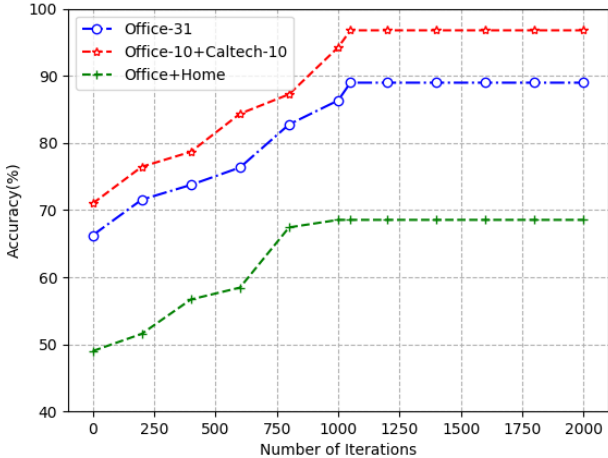
Figure 4. Converge curves of MultiDTNN on three datasets.